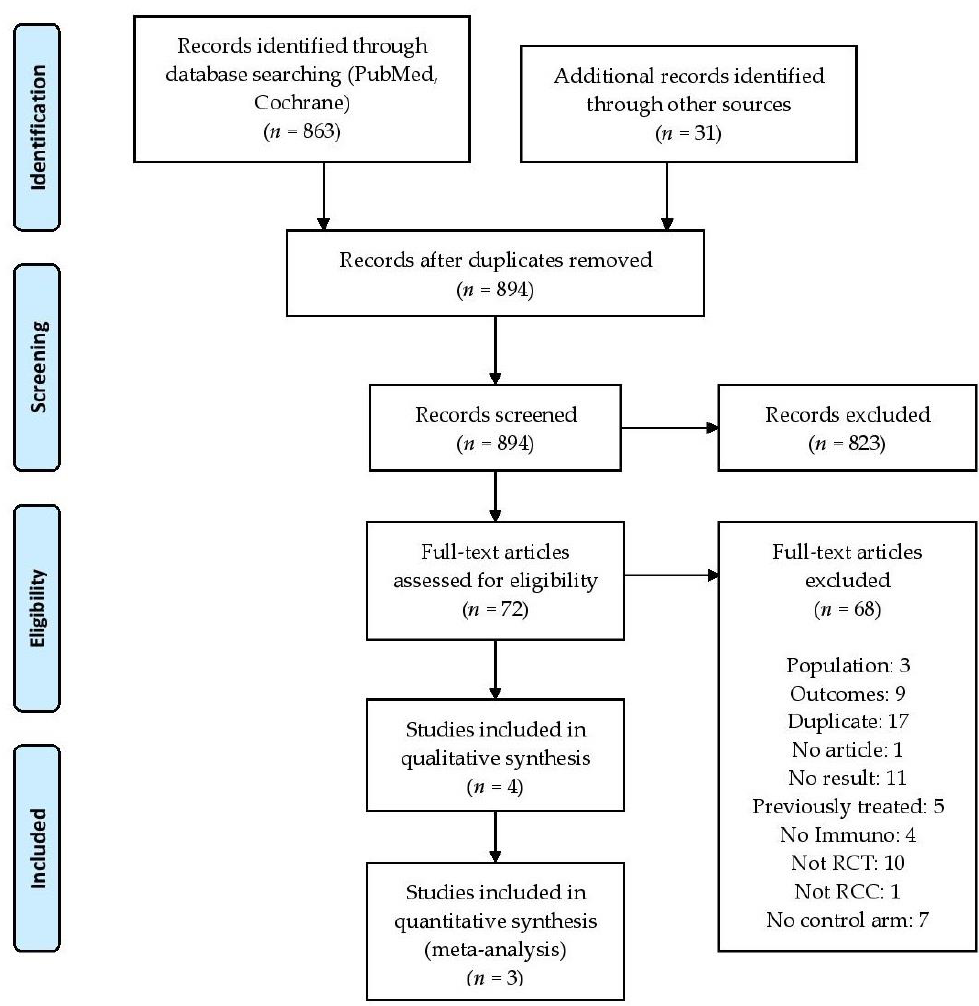
Figure 1. Flowchart of the systematic search. PRISMA flow diagram. Table 1. Outcomes reported in each trial of the network. Ave: avelumab; Axi: axitinib; Ipi: ipili-